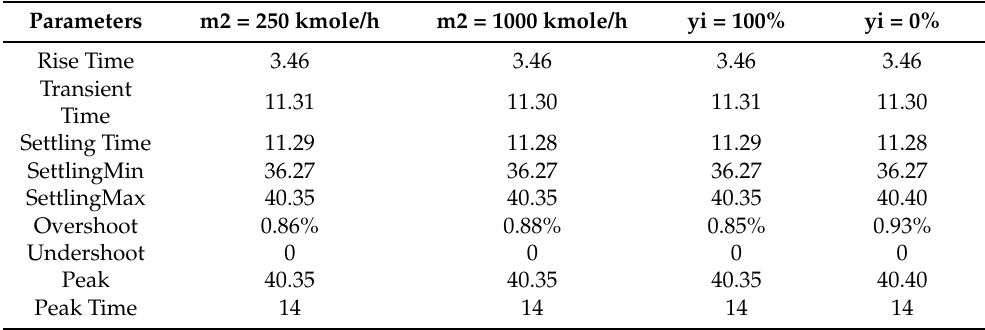
Figure 13. Response of system with reinforcement learning for optimization of PI in case of several values of m2 and yi: ( a ) decrease m2 to 250 kmole/h; ( b ) increase m2 to 1000 kmole/h; ( c ) decrease yi to 100%; ( d ) decrease yi to 0%. Table 4. Step-response characteristics for system in Figure